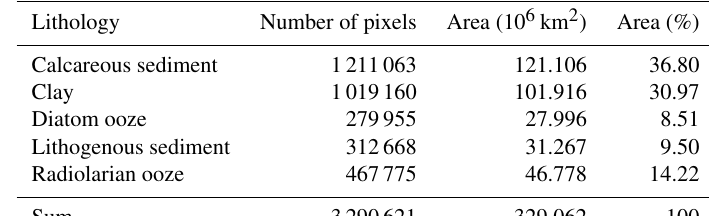
Table 4. Breakdown of areal coverage by lithology types in the global ocean below 500m water depth.